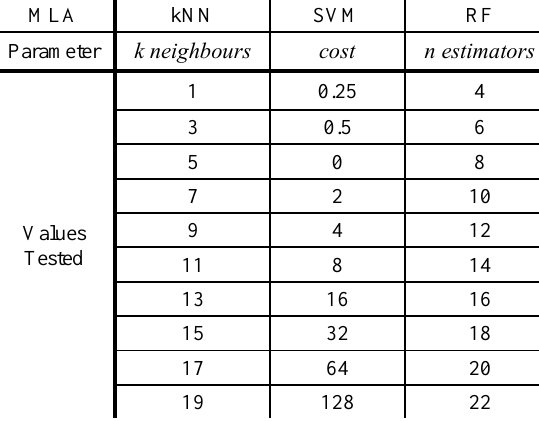
Table 4. Parameter and values tested for each MLA during the cross validation. The cross validation serves to determine which parameter value provides the best performance for each